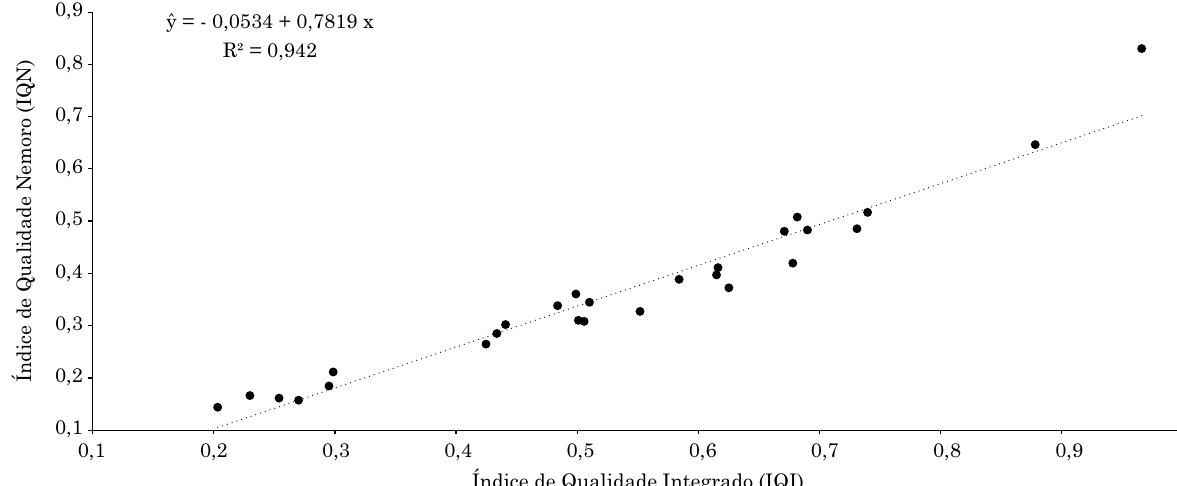
Figura 2. Relação linear entre os índices de qualidade do solo Nemoro (IQN) e integrado (IQI).